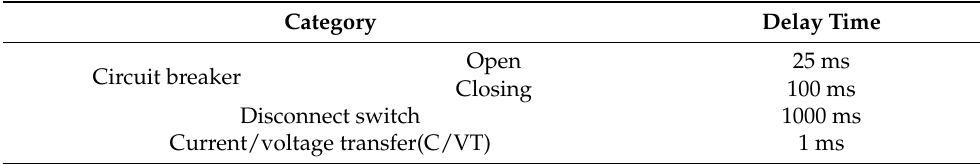
Table 2. Response delay of the primary equipment.